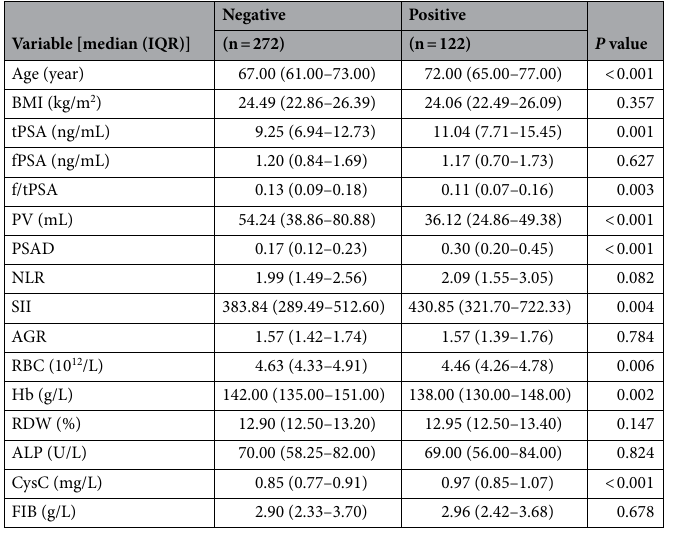
Table 1. Descriptive characteristics of clinical parameters with negative and positive biopsy. IQR interquartile range, BMI body mass index, PSA prostate-specific antigen, tPSA total PSA, fPSA free PSA, f/tPSA free/ total PSA, PV prostate volume, PSAD PSA density, SII systemic immune-inflammation index, AGR albumin to globulin ratio, RBC red blood cell, Hb hemoglobin, ALP alkaline phosphatase, CysC cystatin C, FIB